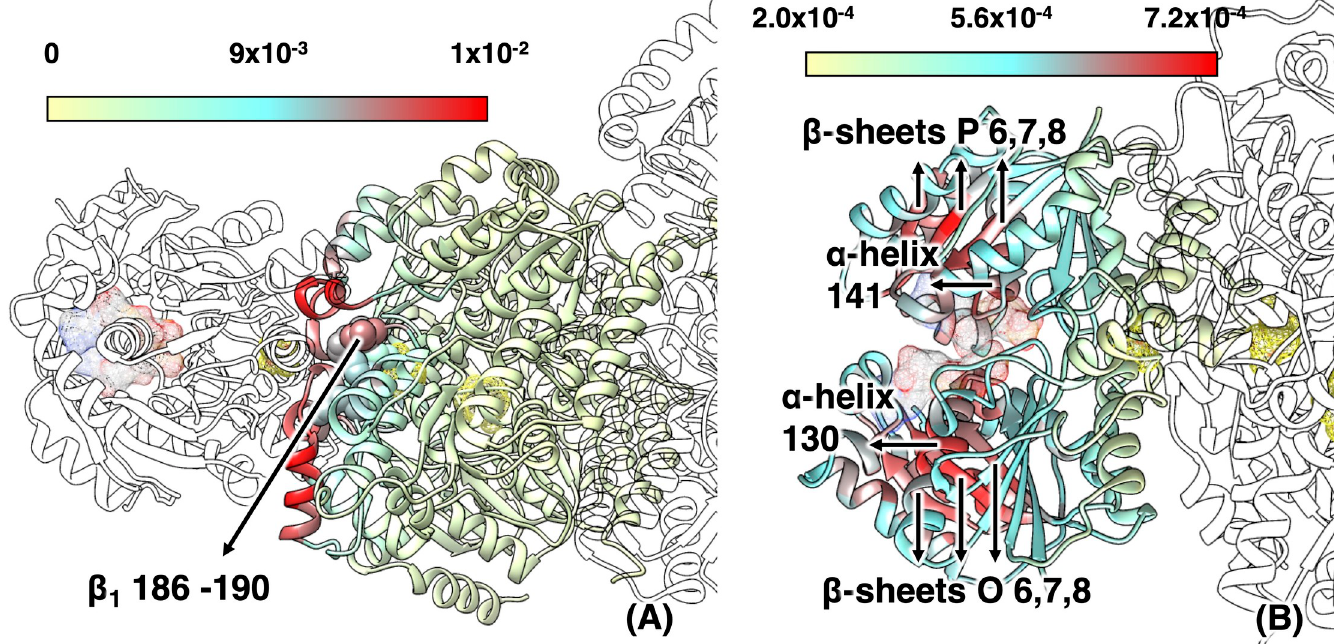
Fig 3. Maximum mechanical coupling M of (A) residues in α 1 β 1 to any residue in Fe 1 and (B) residues in Fe 2 to any residue in Fe 1 in ATP-bound complex. The ATP analogues, [4Fe-4S] clusters, P-clusters, and FeMo-co are shown in mesh surface. Residue 186–190 in β 1 are highlighted in spheres in (A); one α -helix and three β - sheets in each monomer of Fe 2 appear red in (B) (following the numbering in the 2AFK PDB file).